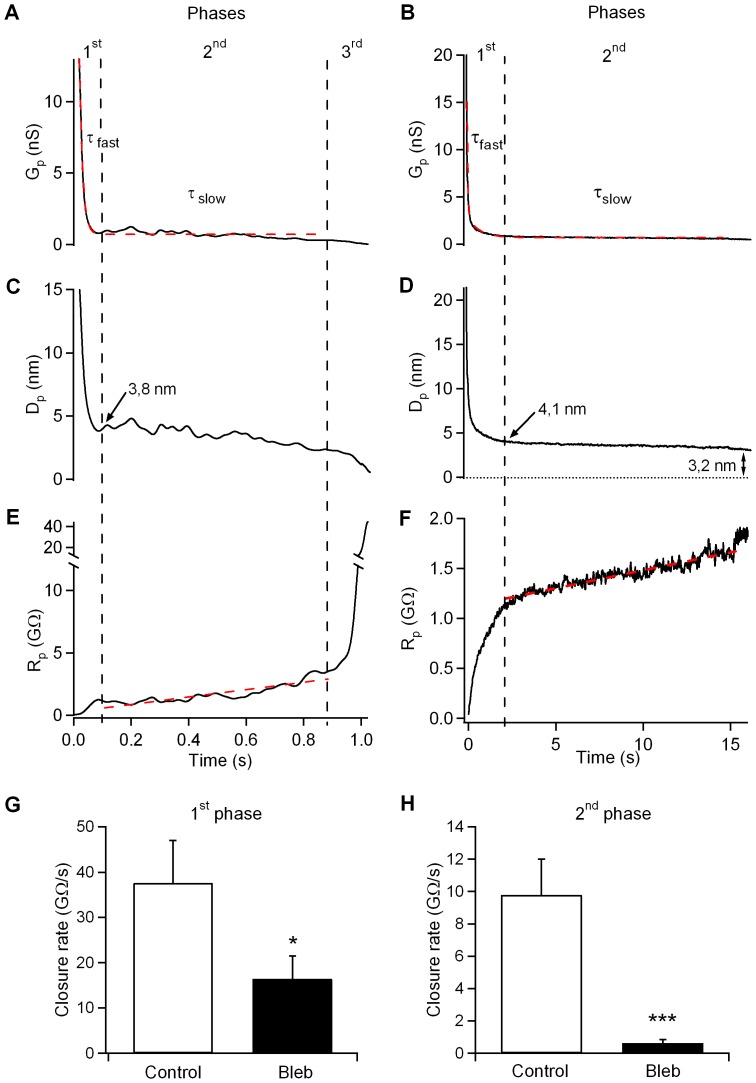
Blebbistatin affects fission pore dynamics.The time–course of Gp showed three different kinetic phases in control cells (A). A double exponential function depicts the two initial phases (red dashed line). A more pronounced Gp decrease accounts for the third phase (not appreciable in this magnification). This last phase is not present in the fission pore from the cell treated with blebbistatin (B). Fission pore diameters (Dp) from control (C) and treated cells (D) were calculated from the conductance data with the assumption that all conductance decreases result from changes in the diameter (assuming a pore length of 15 nm, which corresponds to the thickness of two membrane bilayers). A time–course of fission pore resistance (Rp) was calculated from the conductance data (E and F). The second phase could be fitted to a straight line in both the control pore (E) and the pore inhibited with blebbistatin (F) (dashed line; Pearson’s correlation coefficients: 0.89 and 0.95, respectively). The sudden increase in pore resistance indicated that the final pore closure (third phase) was absent from the pores in most cells lacking NM-2 function. The pore closure rates during the first (G) and second (H) phases in control conditions were higher than blebbistatin-treated pores. Error bars, S.E.M. *p<0.05; ***p<0.001.